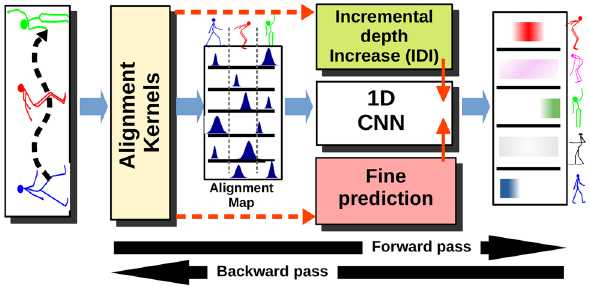
Fig. 1 General overview of DACNN framework. Alignment kernels preprocess the input streams. 1D-CNN performs temporal prediction based on the derived alignment map. The IDI module automatically increases the depth of 1D-CNN. The fine-prediction unit improves the resolution of output